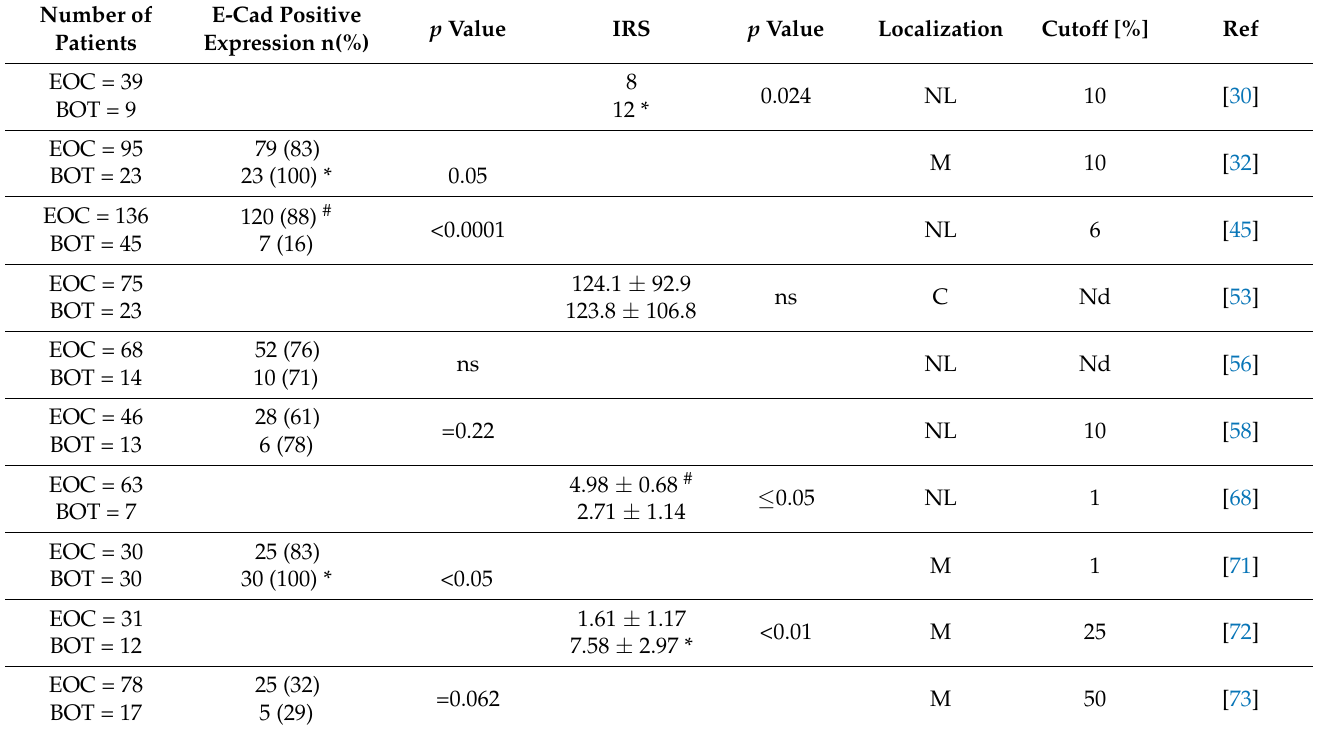
Table 7. The comparison of E-cadherin expression in EOC versus BOT